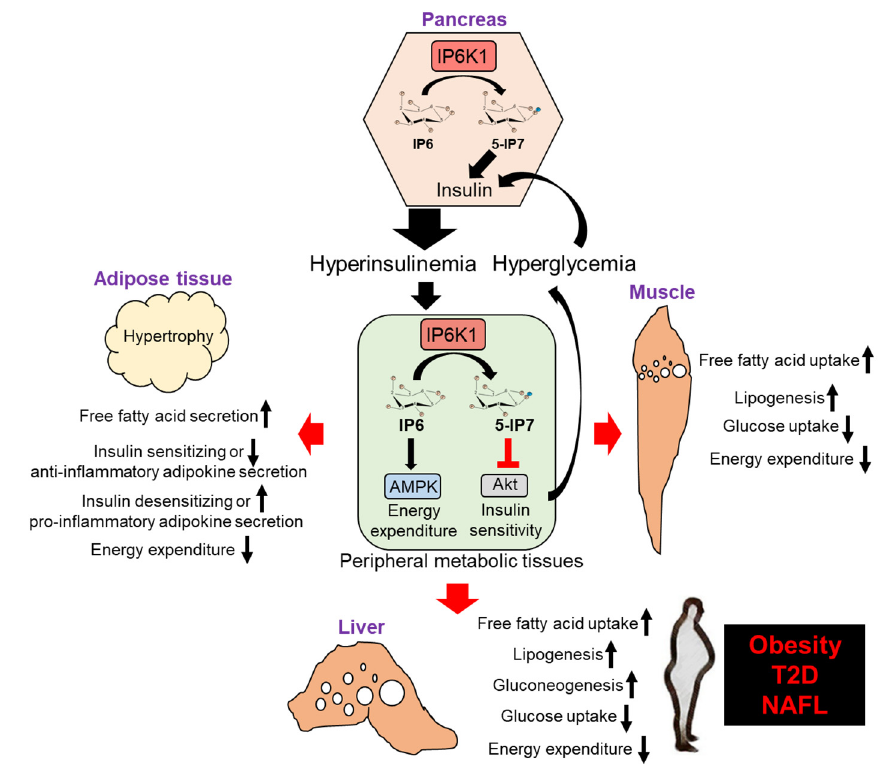
Figure 2. In obesity, 5-IP7 mediated inhibition of Akt causes insulin resistance in metabolic tissues (green box) causes hyperglycemia, which induces 5-IP7 mediated insulin secretion from pancreatic β cells (hexagon), resulting in hyperinsulinemia. Moreover, IP6K1 mediated conversion of IP6 to 5-IP7 reduces IP6 ′ s stimulatory effects on AMPK mediated energy expenditure in the adipose tissue, leading to adipocyte dysfunction. Dysfunctional adipocytes secrete free fatty acids and insulin desensitizing and pro-inflammatory adipokines. Circulating free fatty acids are taken up by the liver from the serum. Although the rate of glucose uptake is lower in this condition, hyperinsulinemia causes a portion of glucose to enter the liver. Gluconeogenesis is also increased. Consequently, the liver accumulates fat (white droplets) by conversion of free fatty acids to triglycerides and de novo lipogenesis. The skeletal muscle also accumulates fat and becomes insulin resistant in a similar fashion. Therefore, increased IP6K1’s actions cause obesity, T2D and NAFL.